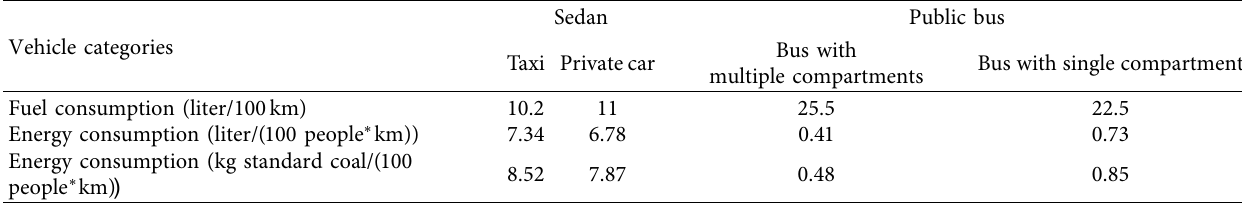
Table 4: Energy consumption comparison of different types of vehicles.